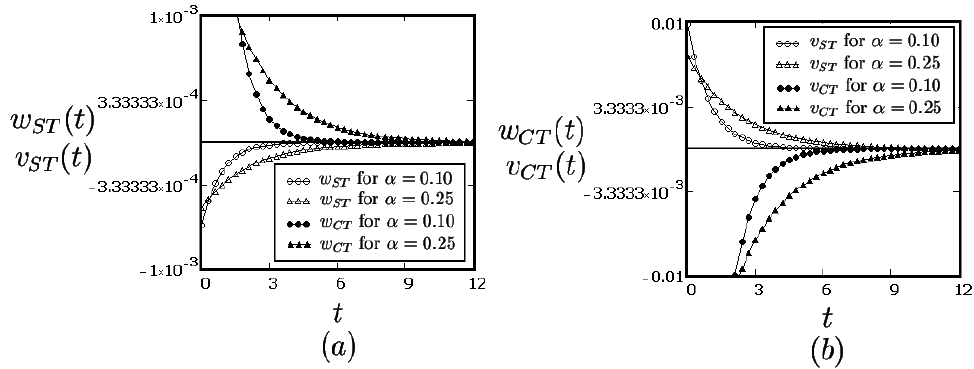
Fig. 1. Decay of the transient components w ST ( r , t ) , w CT ( r , t ) , v ST ( r , t ) and v CT ( r , t ) given by Eqs. (42), (57), (43) and (58), for R 1 = 0.3, R 2 =